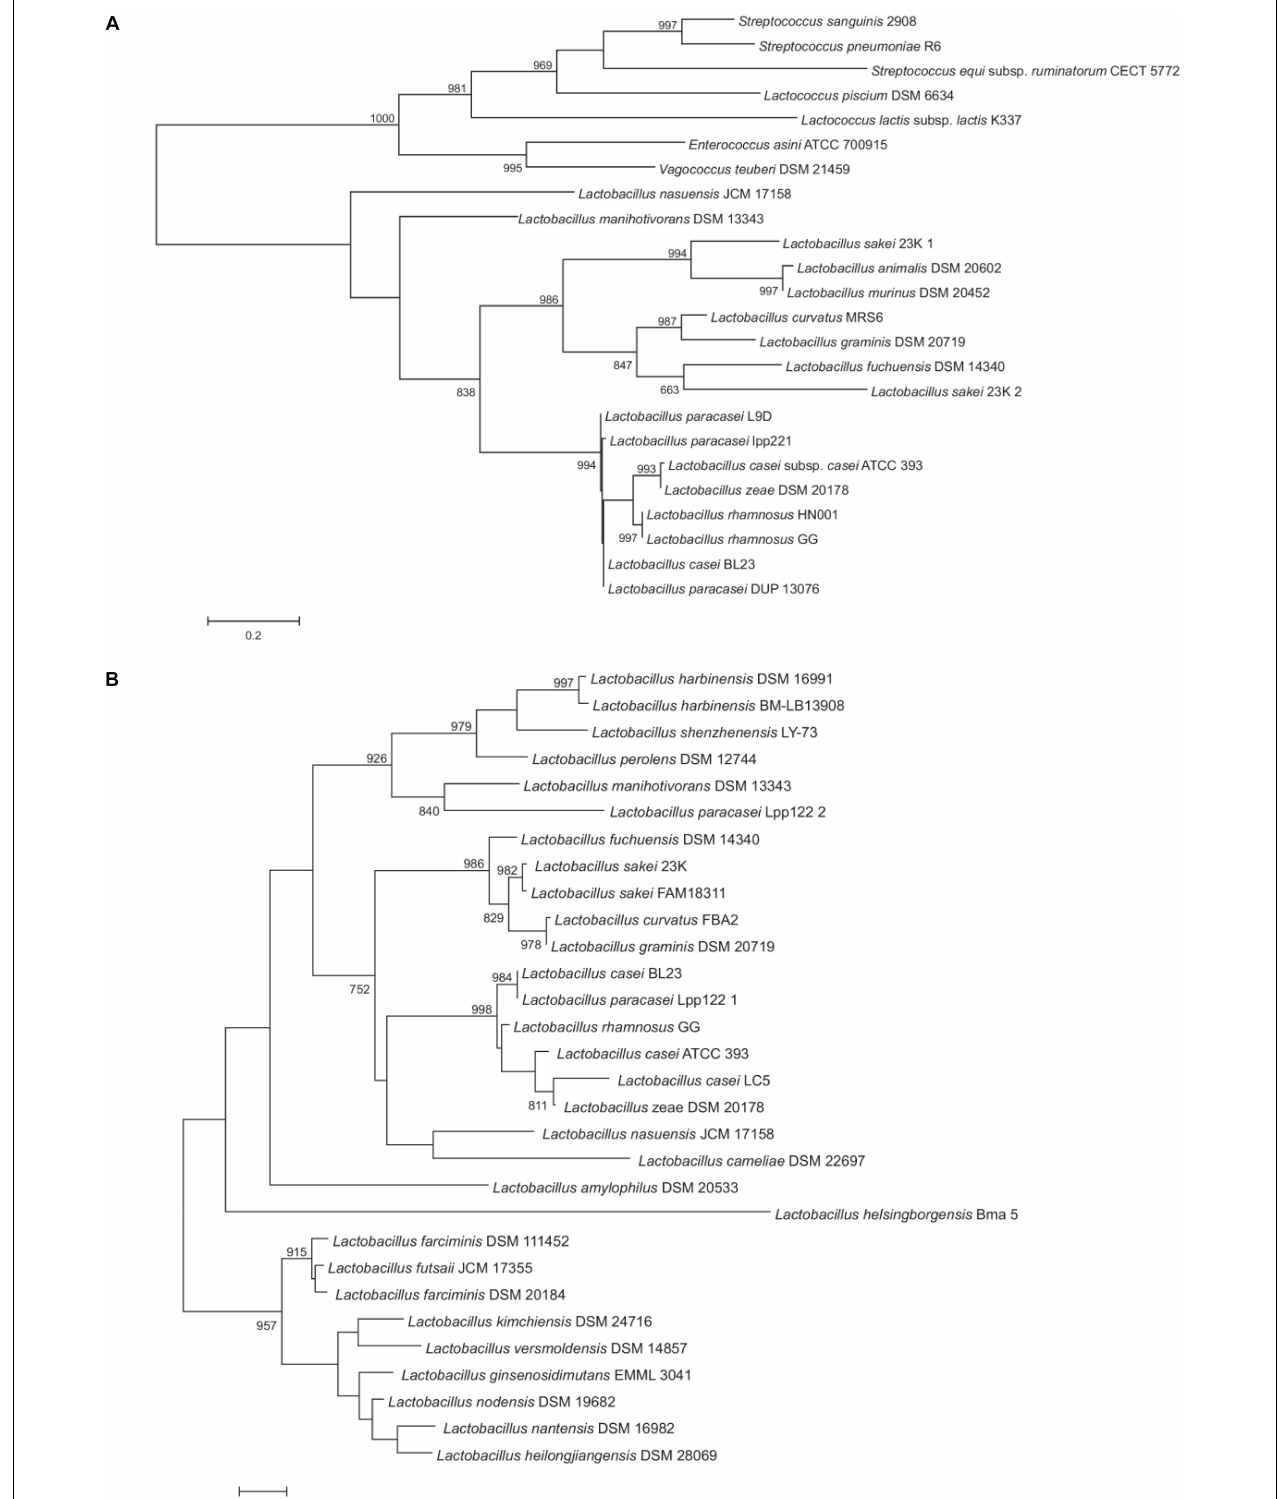
FIGURE 2 | Maximum likelihood phylogenetic trees of representative P40 (A) and P75 (B) protein sequences. The trees have been arbitrarily rooted to facilitate its visualization. Support values higher than 750 for the bootstrap analysis are indicated. Protein sequence codes are supplied in Supplementary Tables S3.1,S3.2 .